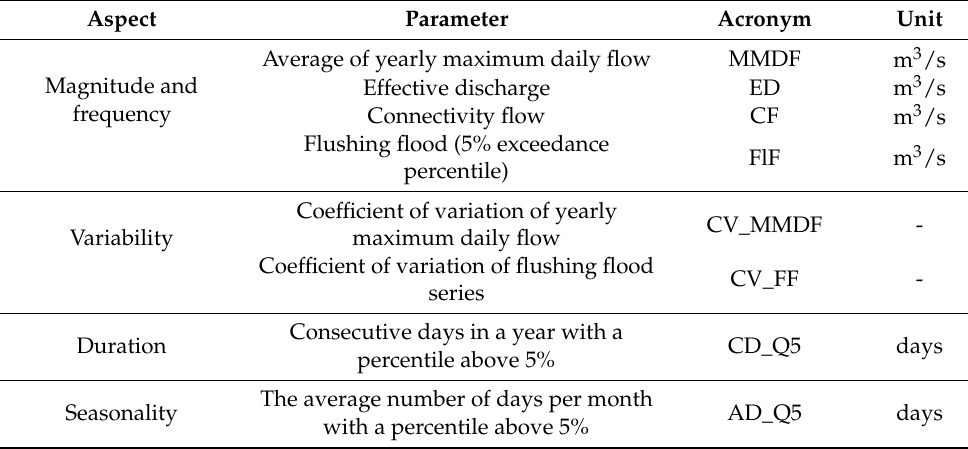
Table 3. Parameters used in this study for flood